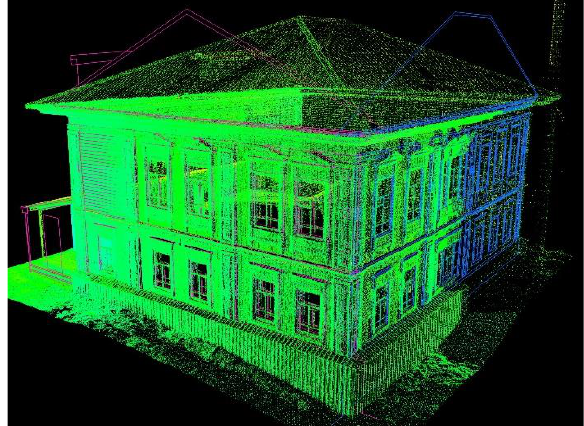
Figure 2 . 3D point cloud of a historical building with design